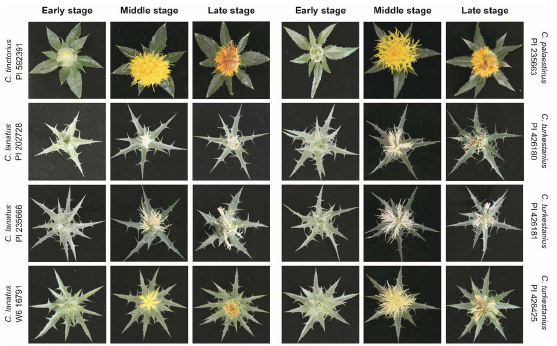
Figure 1. Phenotypes of wild sa ffl owers and cultivars. Sa ffl ower materials were obtained from the USDA (U.S. Department of Agriculture) National Plant Germplasm System via the Germplasm Resource Information Network. C . tinctorius and C . palaestinus florets were orange at the middle stage and became red / orange as development proceeded. Florets of W6 16791 and PI 426425 were yellow at the middle stage, and the pistils became orange as development proceeded. All other materials were white / cream at the middle